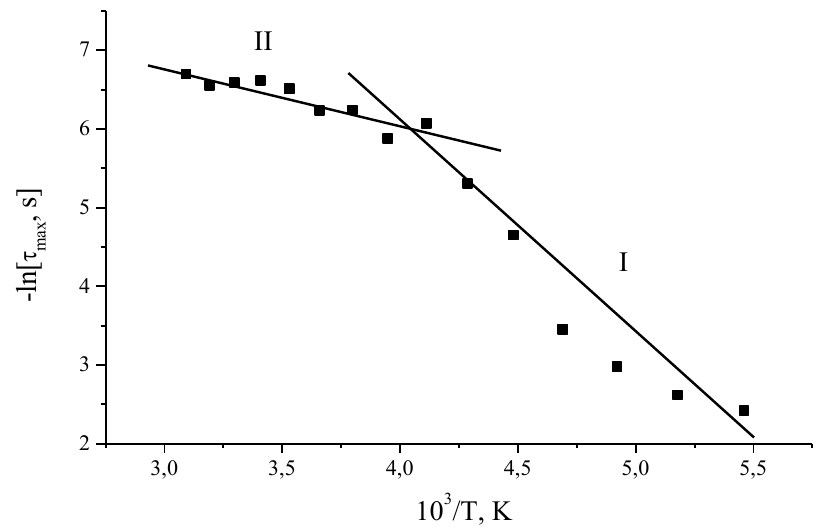
Figure 5. Temperature dependence of the relaxation times of the most probable relaxation time τ max for por-Si layers. The graph reveals two sections with different slope (different activation energies): section I with estimated activation energy E A 1 = 0.25 eV and section II with estimated activation energy E A 2 = 0.08